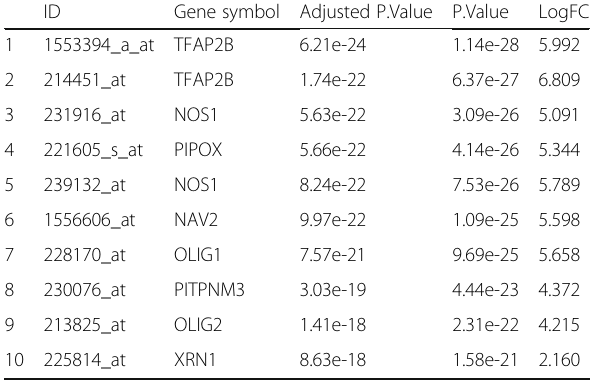
Table 1 List of the top probes/genes highly expressed in PAX3/ 7-FOXO1 fusion positive tumours (GEO, GSE66533 set) ID Gene symbol Adjusted P.Value